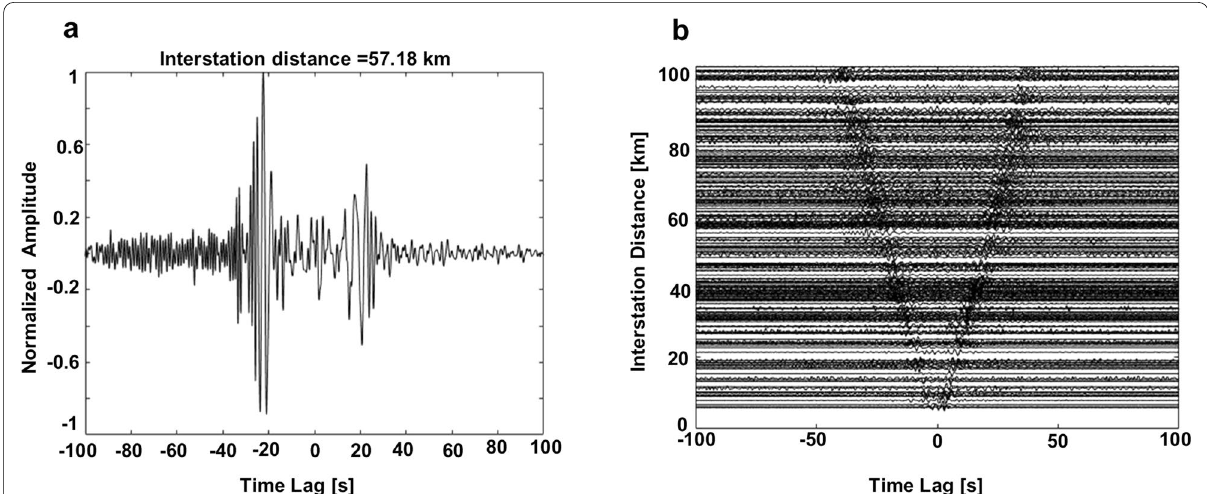
Fig. 2 Cross-correlation functions showing the empirical Green’s functions between station pairs for frequencies ranging from 0.05 to 1.0 Hz. a Cross-correlation function for a station pair with an interstation distance of 57.18 km (shown in Fig. 3b), and b stacked cross-correlation functions from randomly selected station pairs, exhibiting Rayleigh wave propagation between paired seismic